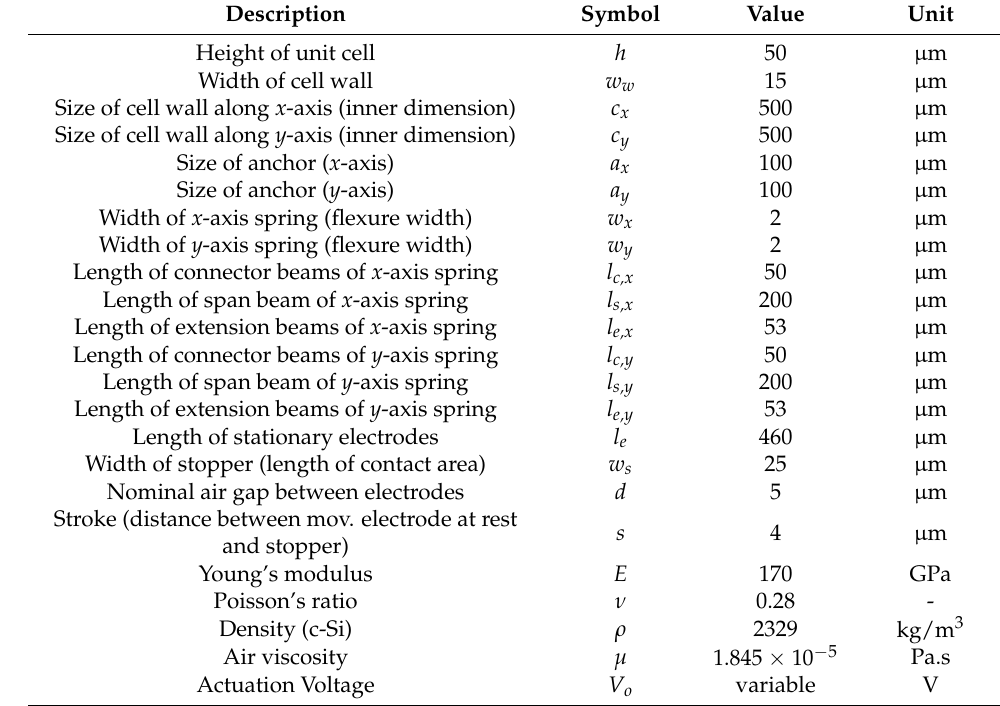
Figure 4. Lumped-parameter modeling of the AUC as a parallel-plate capacitor with squeeze-film damping. m eq is the moveable plate’s equivalent mass, k eq is the serpentine flexures’ equivalent